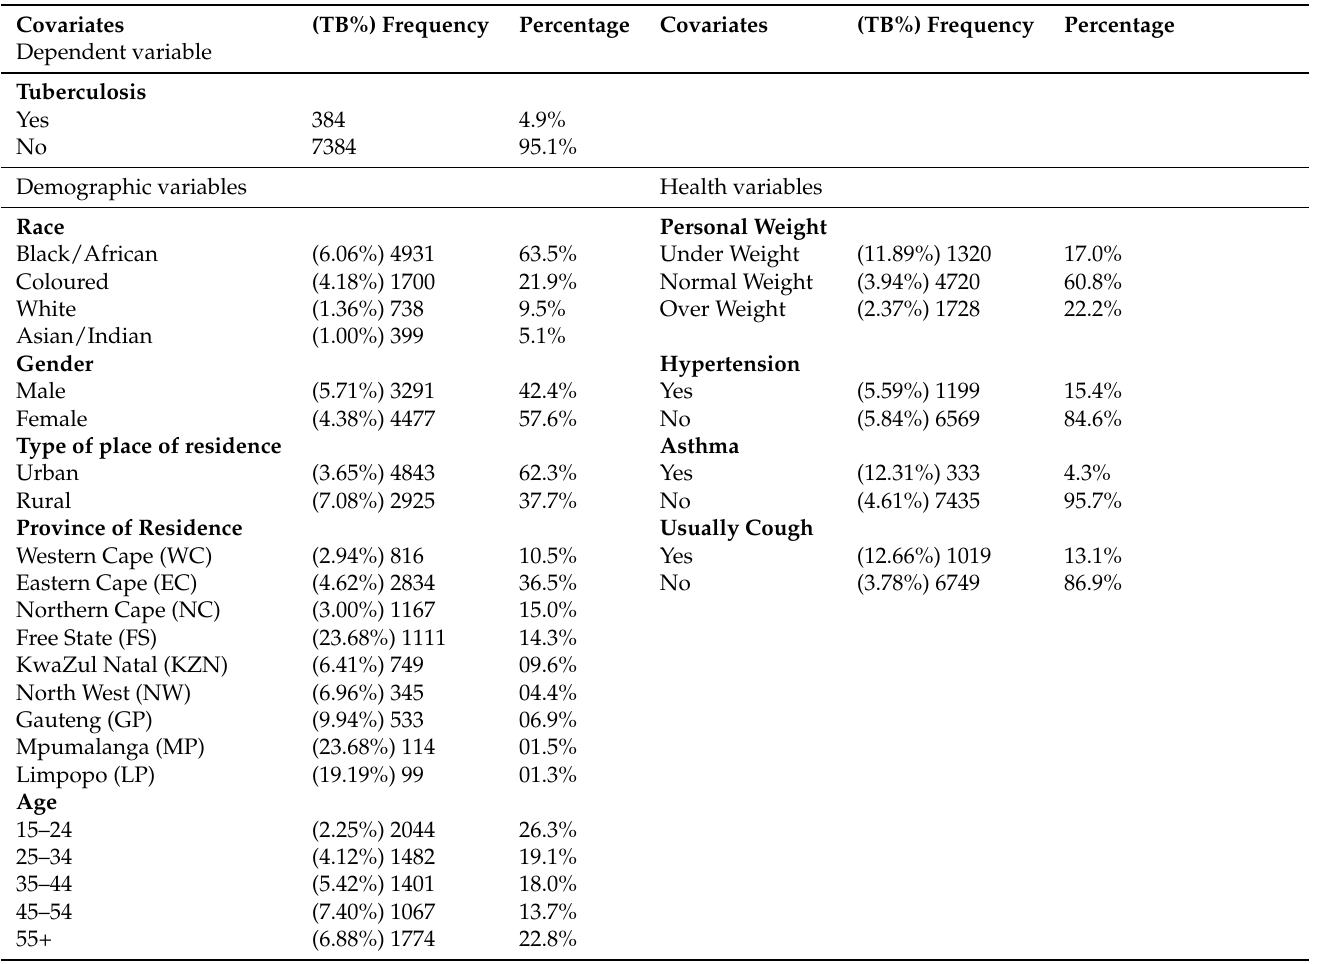
Table 1. Descriptive statistics for dependent and predictor